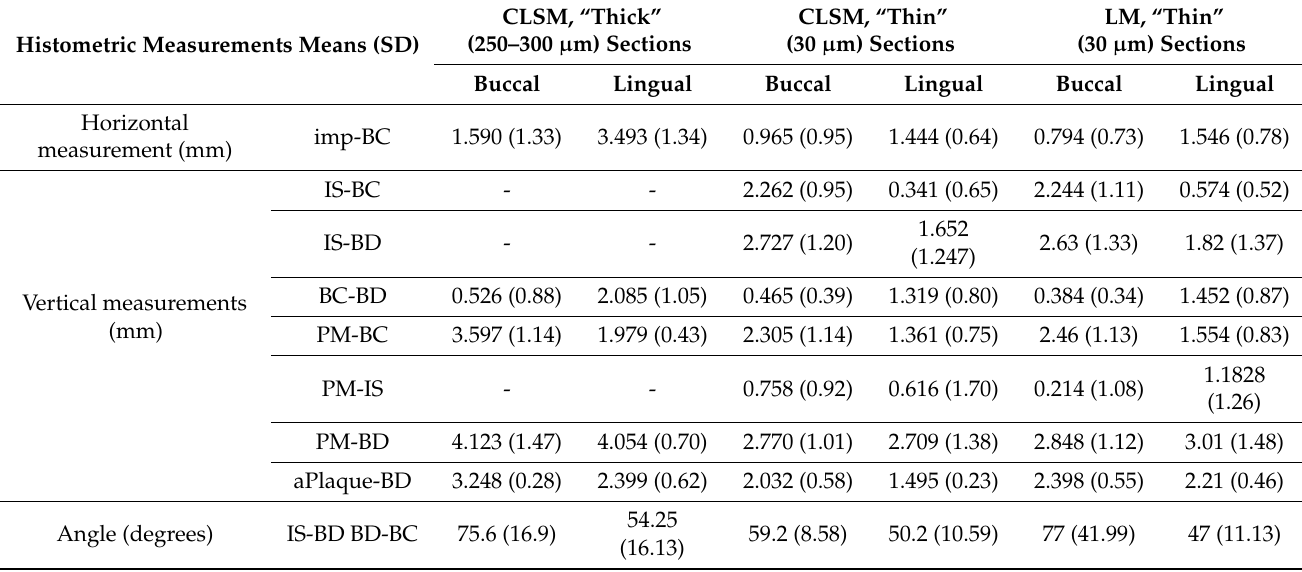
Table 2. Histomorphometric results: measurements performed on “thick” and “thin” sections in CLSM; for comparison, LM thin sections were used (mean values and standard